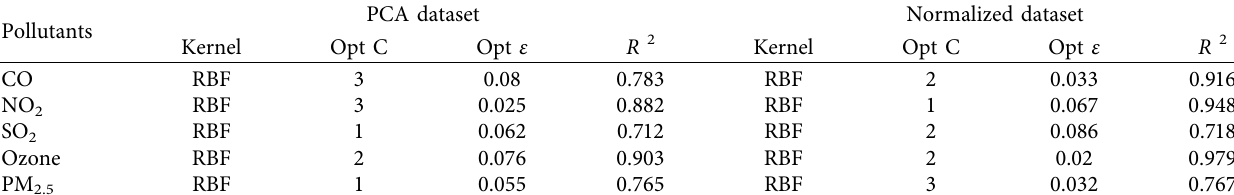
Table 5: Random search optimal parameter results per pollutant dataset.